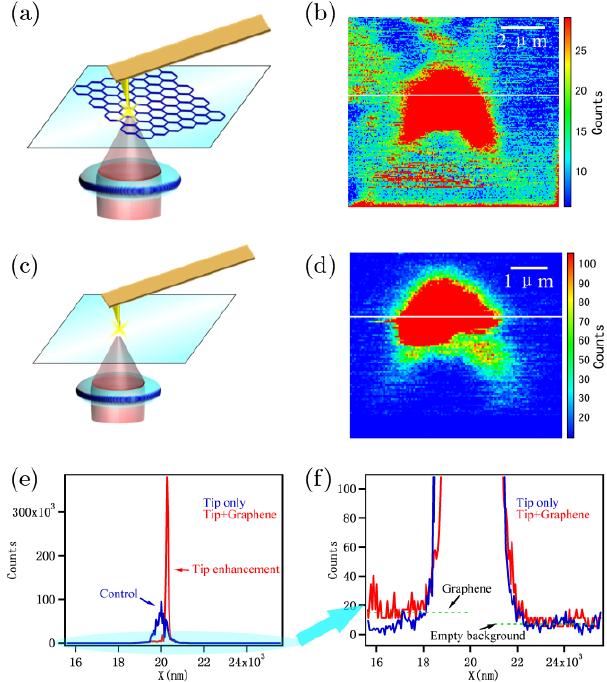
Fig. 5. The measurement of tip enhancement e®ect. (a) and (b) The CARS imaging of both graphene and Au coated tip. (c) and (d) The control group in which only tip was imaged by CARS. (e) and (f) The signal intensity measurement of the white line in (b) (red) and (d) (blue).